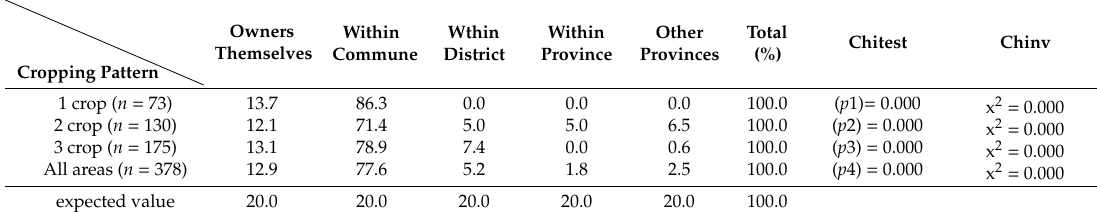
Table 4. Origin of tractor service providers for rice cropping land preparation (%).